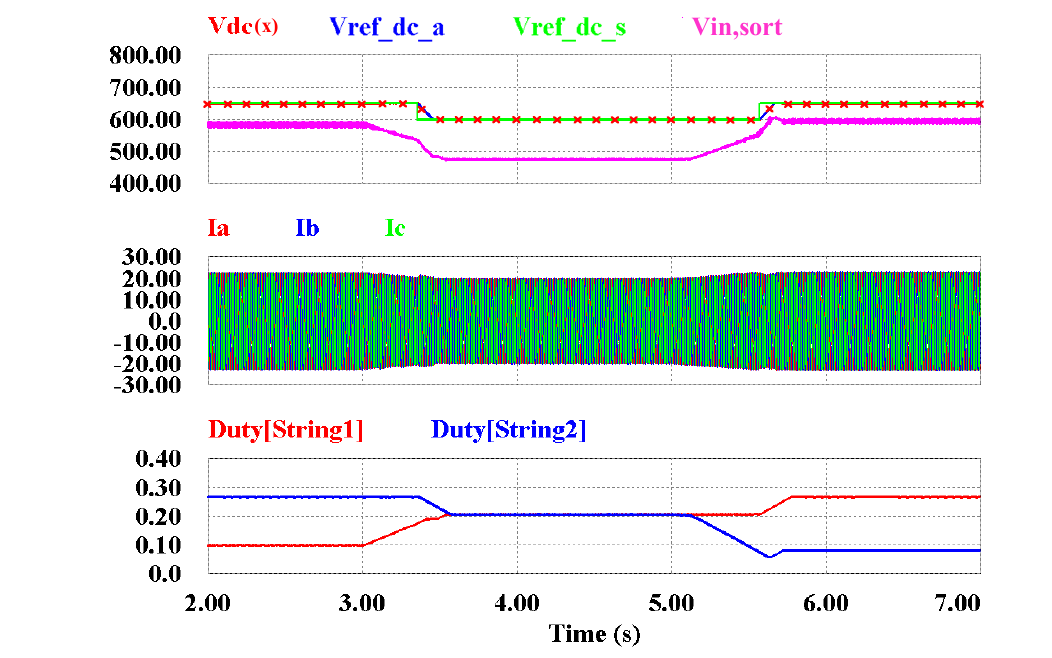
Figure 15. Simulation results for the DC-link voltage, V currents and duty-cycles of the boost converters when the temperatures are changed.